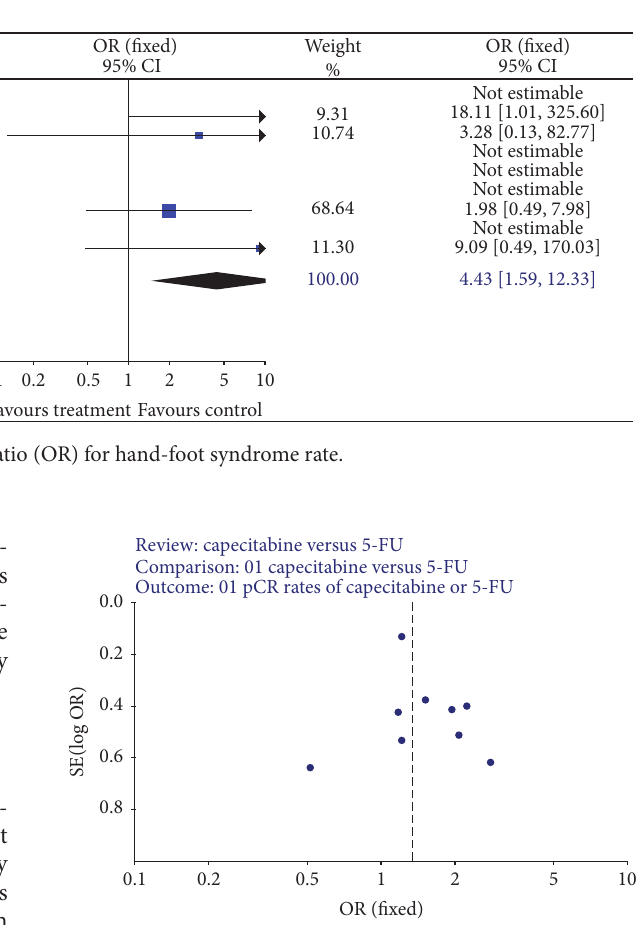
Figure 12: Funnel plot of studies included in this meta-analysis.